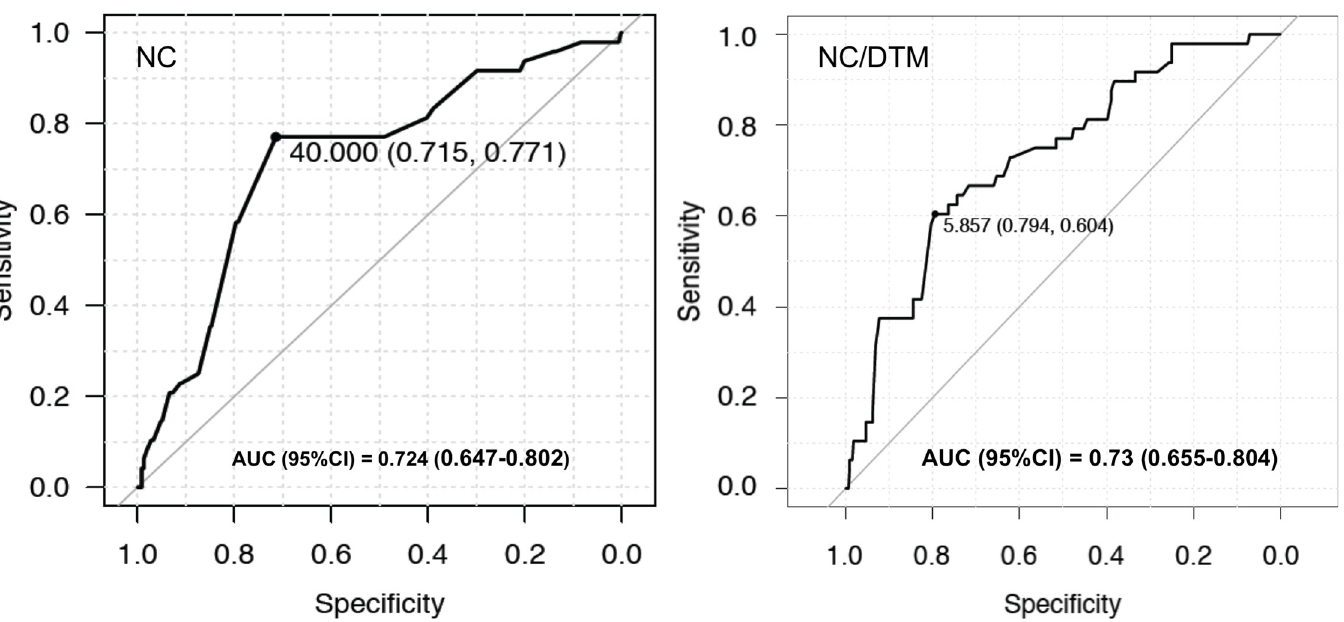
Fig 4. Receiver operating characteristic (ROC) curves with area under ROC curve (AUC) values (95% confidence intervals) for neck circumference (NC) measurement and the ratio of the NC to thyromental distance